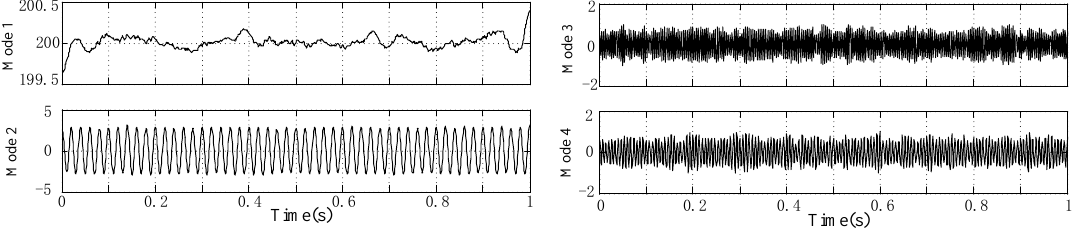
Figure 8. Waveforms of input DC voltage under noise-free condition: ( a ) amplitude, ( b ) spectrum. As shown in Figures 9 and 10, the input DC bus voltage is decomposed different modes by utilizing the VMD-HT and EMD algorithm. With the VMD-HT algorithm, the ripple components with constant and time-variant amplitude are extracted accurately, while the modal aliasing problem will occur when utilizing the EMD algorithm.